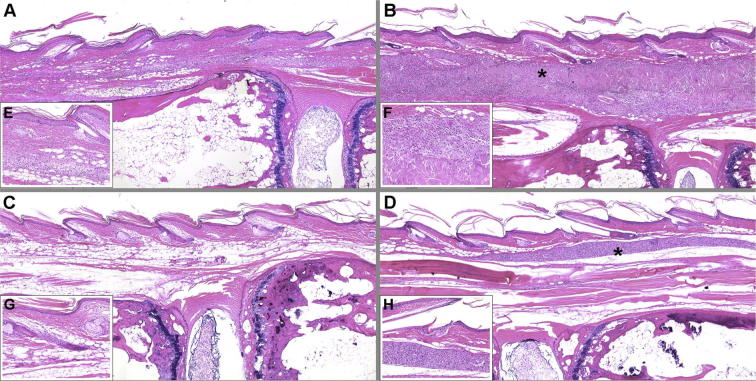
The base-of-tail immunization site of mice treated with Alhydrogel® adjuvant contains a severe inflammatory infiltrate that is absent at the immunization site of mice treated with CLDC adjuvant. BALB/c mice (n = 5 animals) were immunized s.c. at the base of the tail with MAX using either Alhydrogel® or CLDC as adjuvant, and were challenged subcutaneously in one hind footpad with 1 x 103Lm metacyclic promastigotes admixed with 10 ng synthetic FL-MAX. At various time points following immunization, tails were harvested, sectioned, and H&E stained for evaluation of histopathologic changes at the site of immunization. Direct comparison of representative tail sections of CLDC-adjuvanted (A & E) vs. Alhydrogel®-adjuvanted mice (B & F) 14 days post-boost reveals the presence of a severe inflammatory infiltrate (asterisk) at the site of immunization in the Alhydrogel®-adjuvanted group, which is minimal to absent in the CLDC-adjuvanted group. By 245 days post-boost, the tail section from the CLDC-adjuvanted group (C & G) appears normal in comparison to tail sections from un-immunized control mice (not shown), while the severe inflammation persists within the Alhydrogel®-adjuvanted group (D & H). Images are representative of results obtained from three independent experiments. Overview: 10x magnification, inset: 20x magnification.